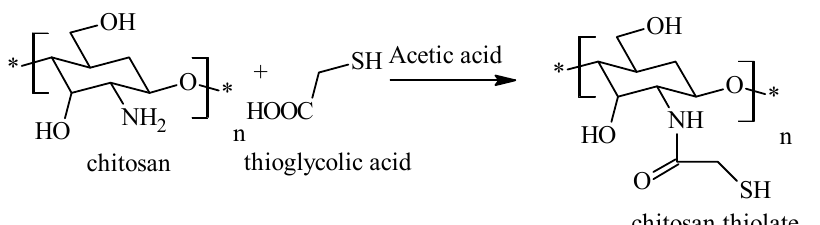
Figure 3. Scheme for the preparation of chitosan thiolate.